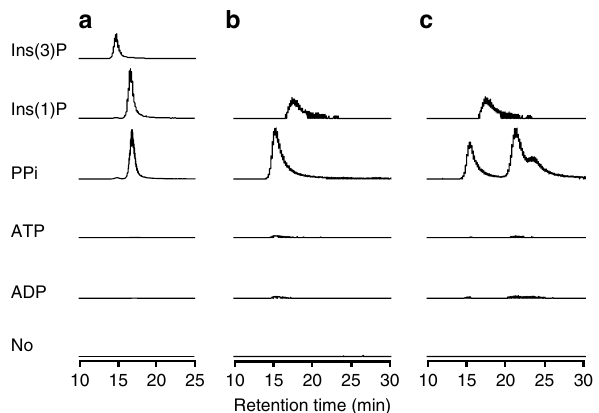
Fig. 2 Analyses of the phosphate donor and the product. LC-MS analyses on the myo -inositol monophosphate produced from the reactions with TM0415 ( a ), homolog No. 7 ( b ), and homolog No. 49 ( c ). Ins(1)P and Ins (3)P represent the authentic compounds, and “ No ” means that the reaction was performed without phosphate donors. Eluted myo -inositol monophosphate was detected by MS with a mass range of m/z 259.0211 –